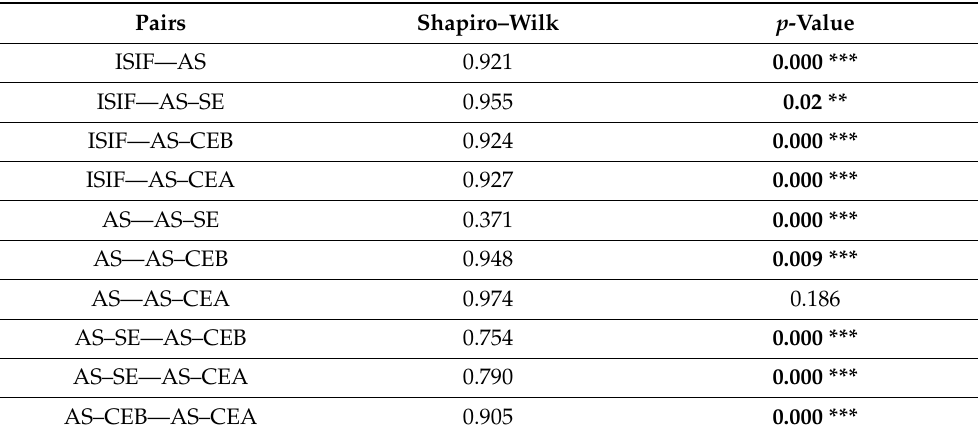
Table 9. Shapiro–Wilk Test for bivariate normality.